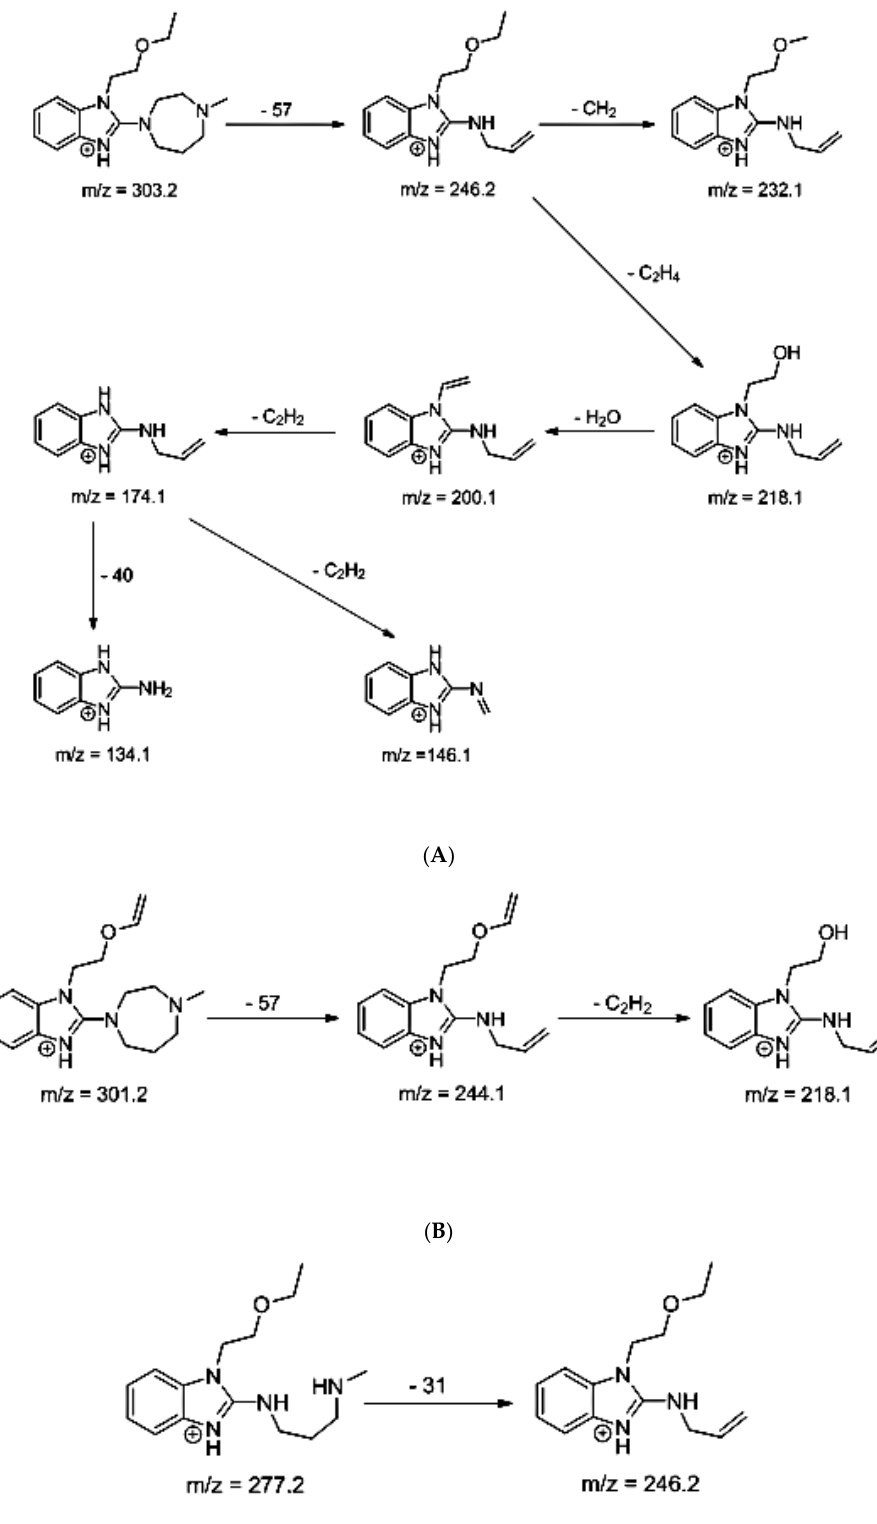
Figure 5. Proposed fragmentation patterns of emedastine (EME) ( A ), EME-P1 ( B ), and EME-P2 ( C ).